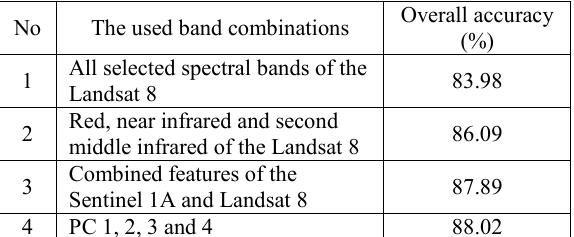
Table 3. The overall classification accuracy of the classified images